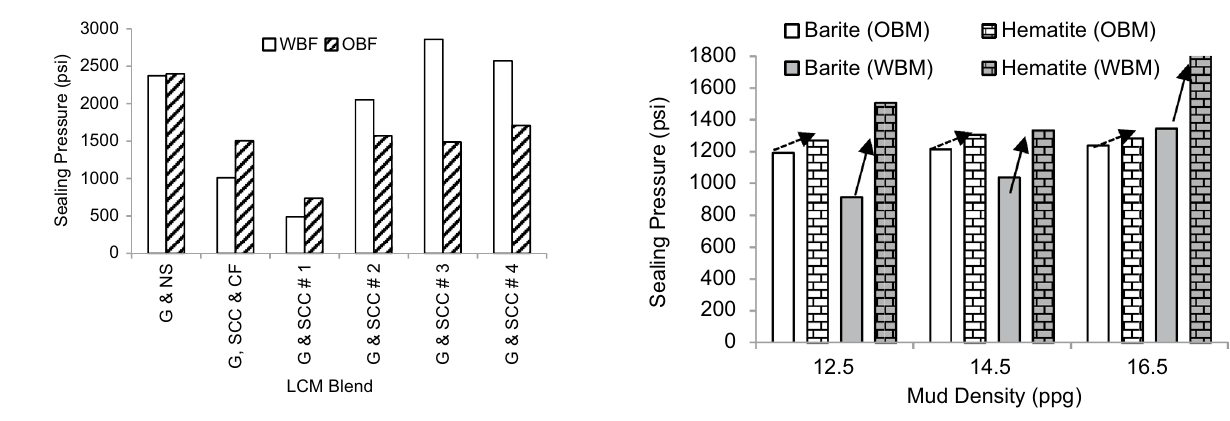
Fig. 5 The effect of weighting materials between barite and hematite. In WBF, the weighting agent used was only barite or hematite, but in OBF, the 11 ppg barite-treated drilling fluid’s density was increased to the target density using barite or hematite